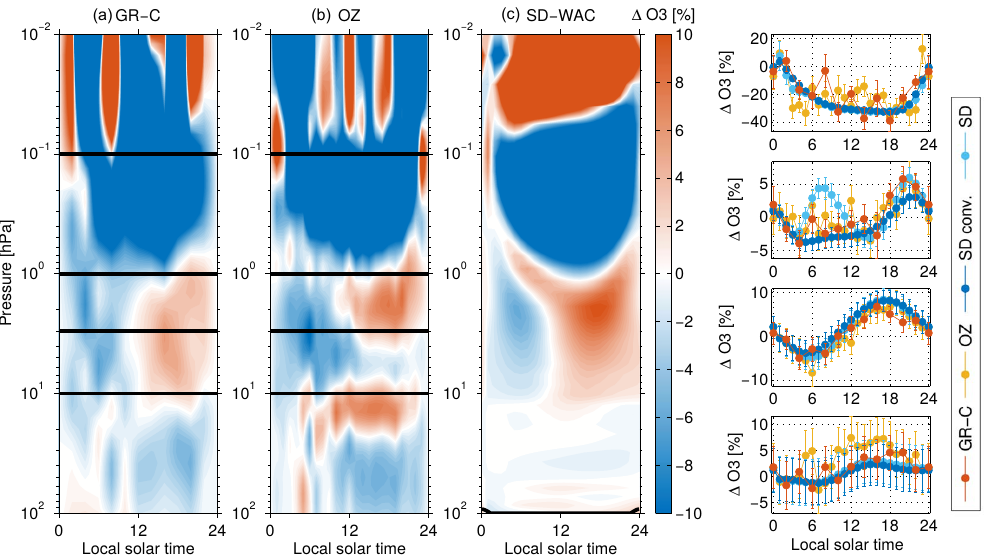
Figure 11. Same as in Fig. 9 but averaged over 10 days starting on 10 April 2016. Note that polar day is now at all altitudes. The strong diurnal cycle in the mesosphere is noteworthy. At the pressure level of 1hPa two maxima exist. The morning maximum is, however, very narrow in altitude.